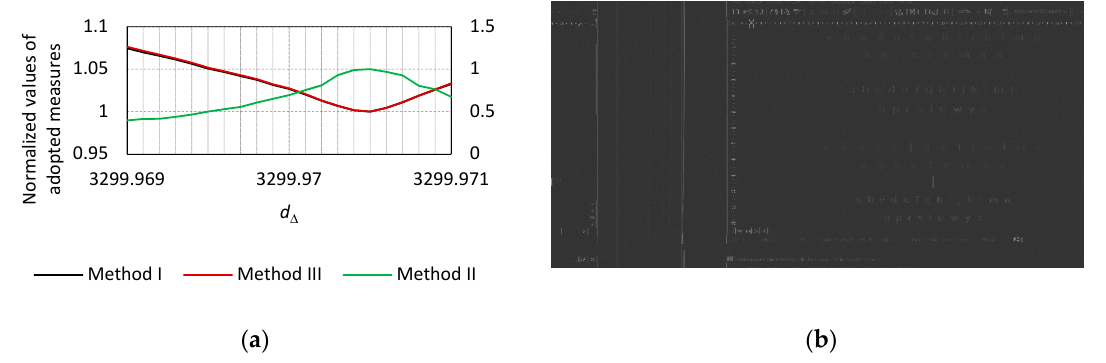
Figure 28. ( a ) The normalized values of the adopted measures (method I, II and III) calculated in domain of image line length 𝑑 ∆ for the accuracy ∆= 0.0001 (for the original image shown in Figure 7d) and ( b ) image reconstructed on the basis of the recorded revealing emission signal at frequency 𝑓 (cid:3042) = 740 𝑀𝐻𝑧 (receiving bandwidth 𝐵𝑊 = 50 𝑀𝐻𝑧 ) for estimated line length 𝑑 ∆ = 3299.97050 (accuracy ∆= 0.0001 )—multiple of image summation 𝑆𝑢𝑚 (cid:3014)(cid:3021)(cid:3013) = 60 , the source of revealing signal emission—display monitor, VGA standard.